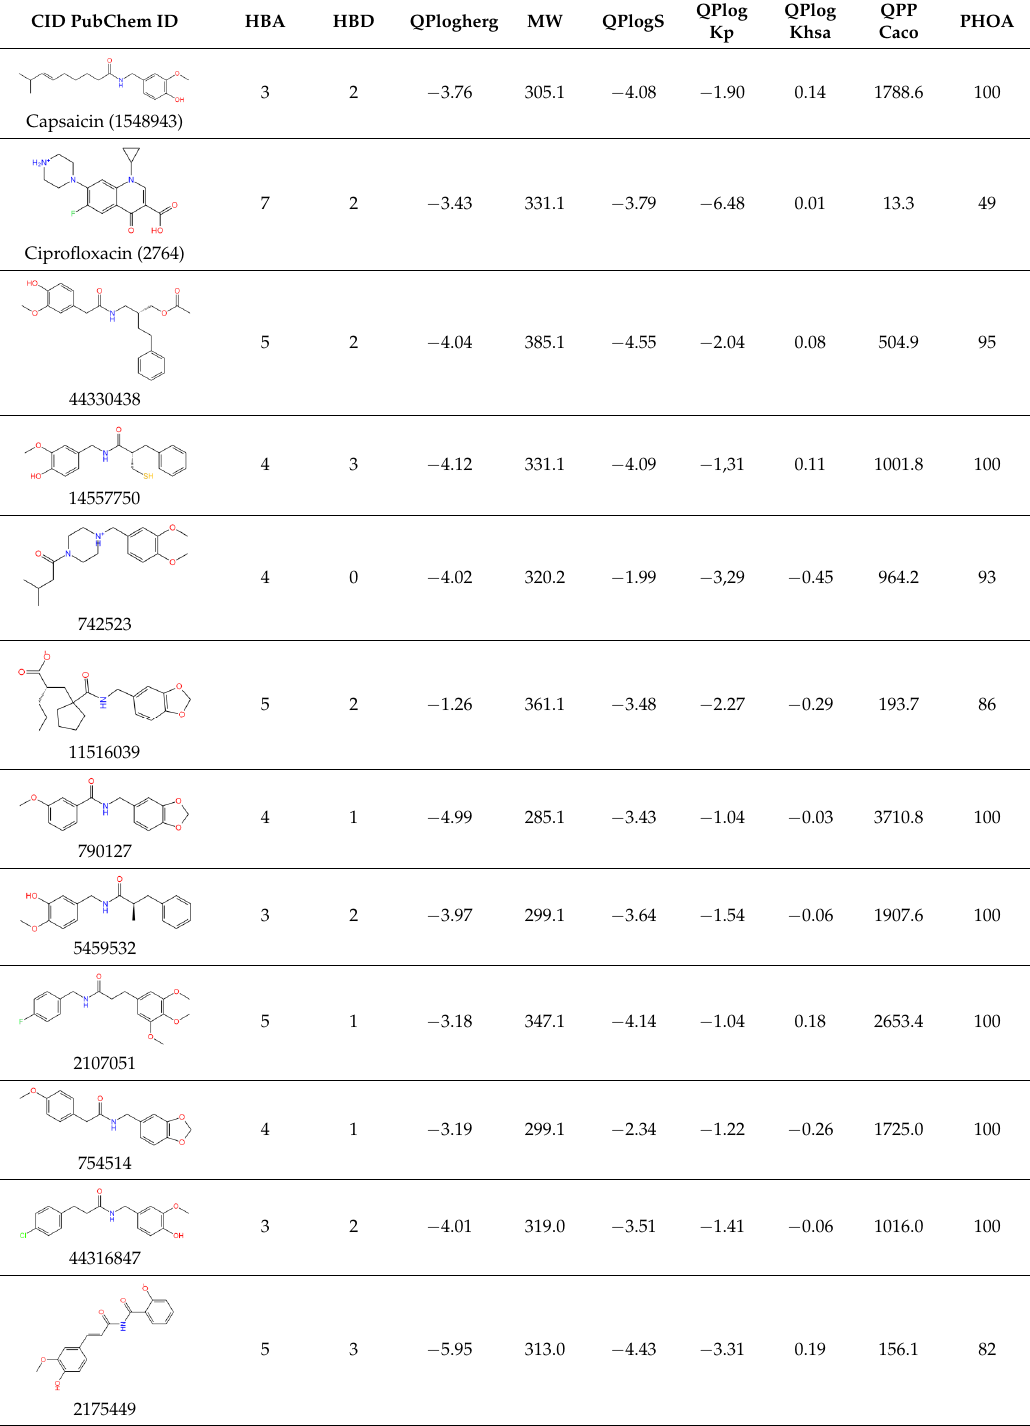
Table 2. Computational prediction of drug likeness properties of potential new lead compounds.